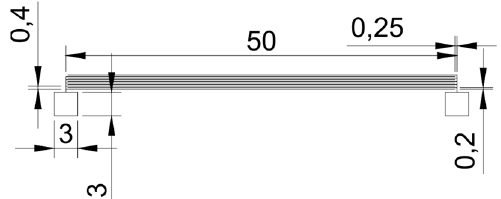
Figure 1. The designed comb-shaped electrode with dimensions in millimeters. Two contact pads 3 × 3 mm with 50 mm pitch, are used to connect external measuring systems. Each electrode has 5 lines with 250 µm pitch.